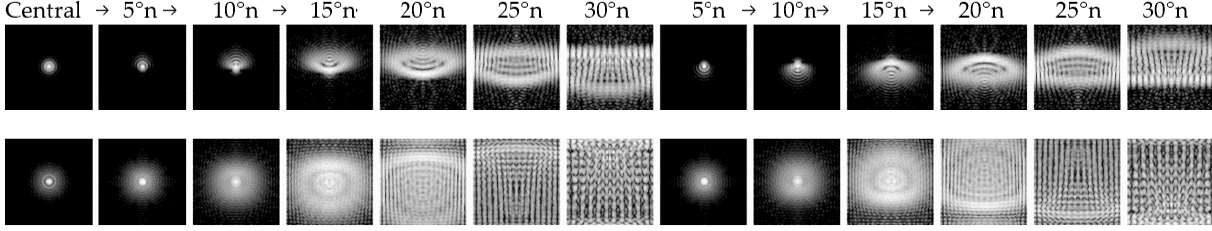
( Bottom row ): Proclear multifocal. Viewing distance at infinity.